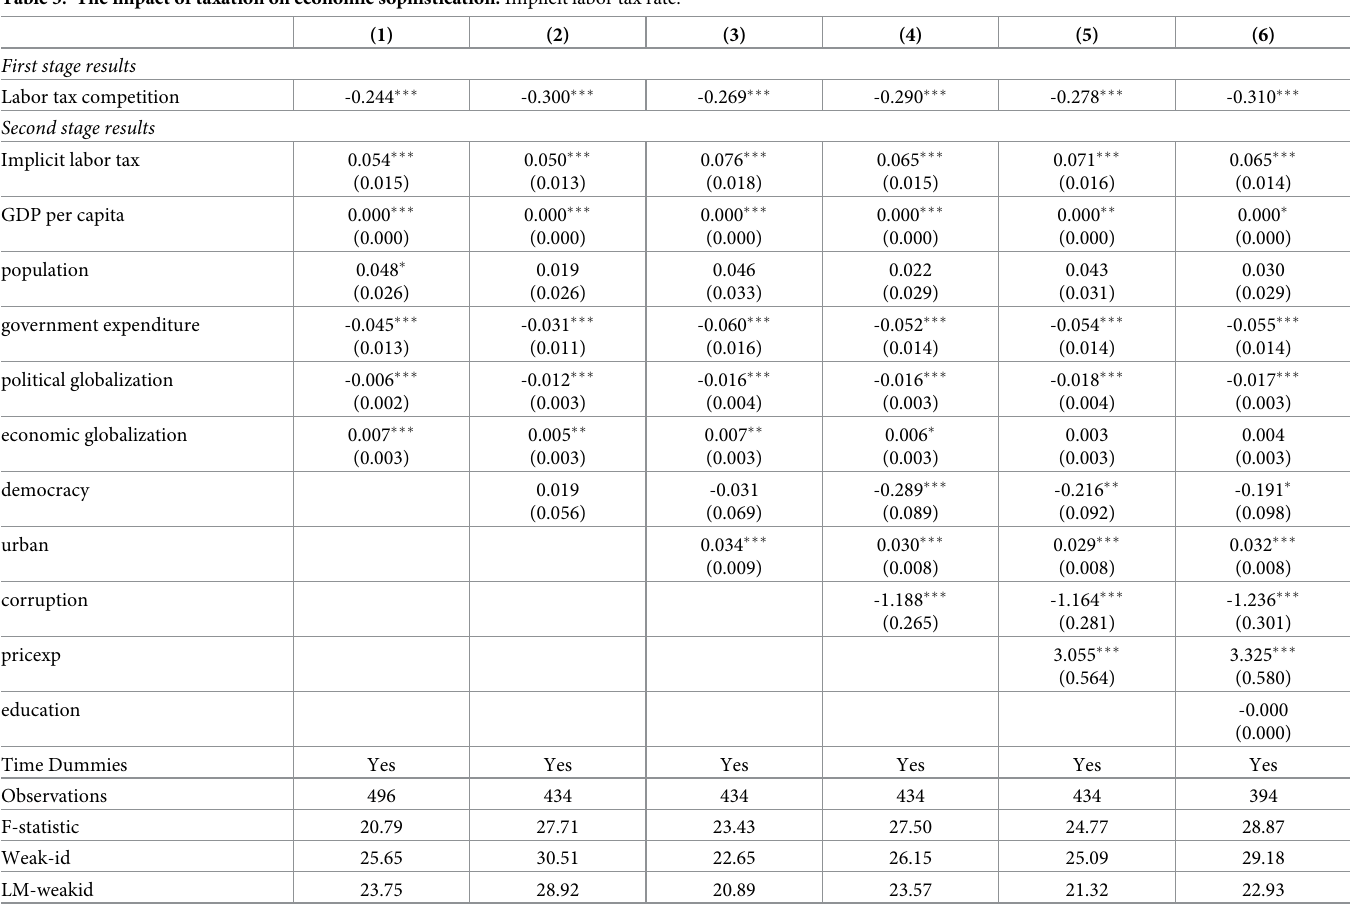
Table 3. The impact of taxation on economic sophistication: Implicit labor tax